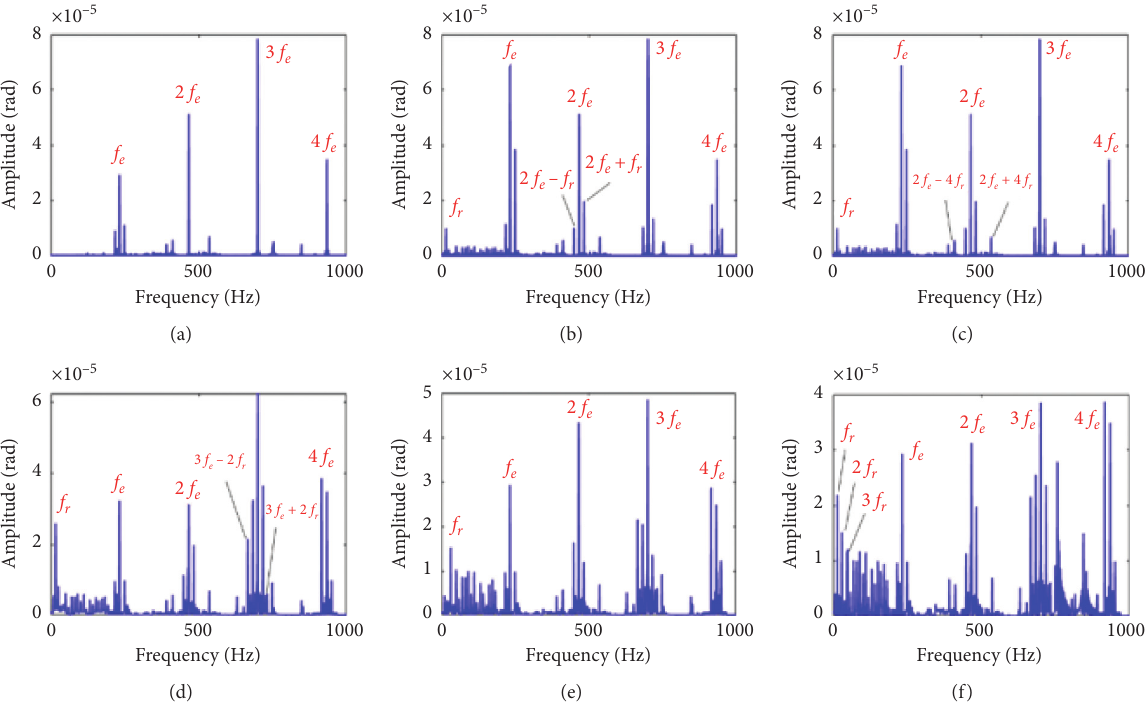
Figure 10: The spectrum diagram of the broken tooth failure. (a) Normal teeth. (b) 20%. (c) 30%. (d) 40%. (e) 50%. (f) 60%.